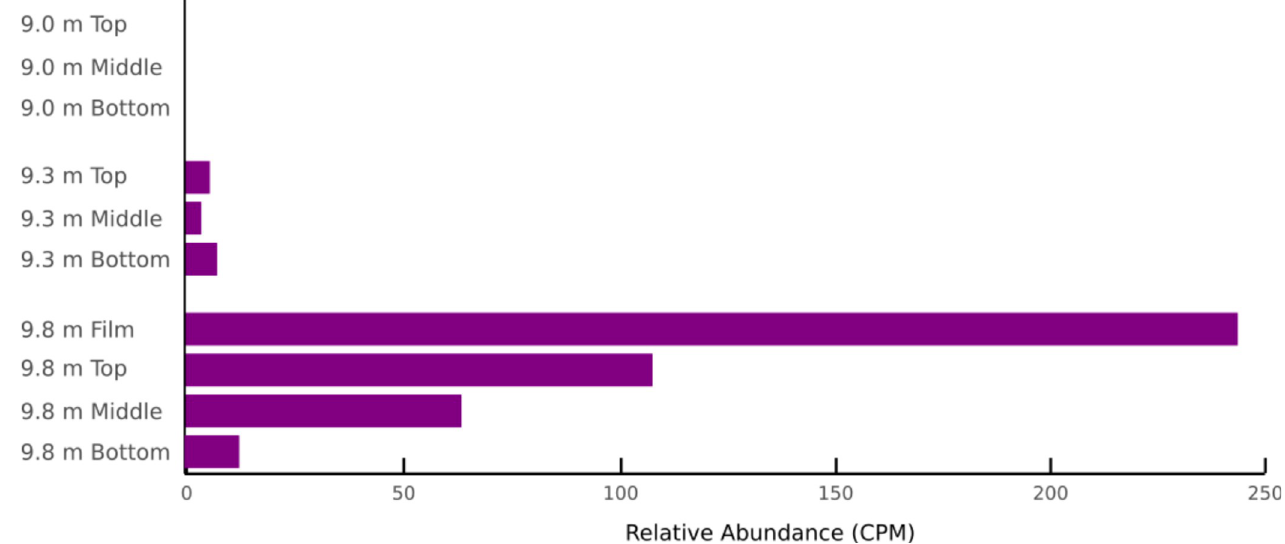
Fig 6. Relative abundance of hdrB . Estimated from metagenomic sequence data varies significantly with water depth and among layers at 9.8 m.